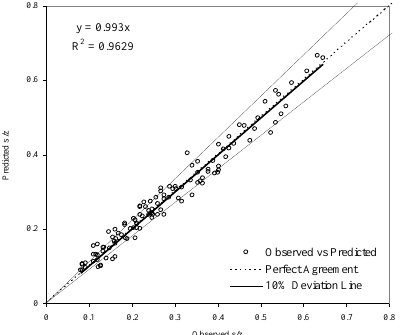
Figure 3. Comparison between observed and predicted equation (11) to estimate s/z .